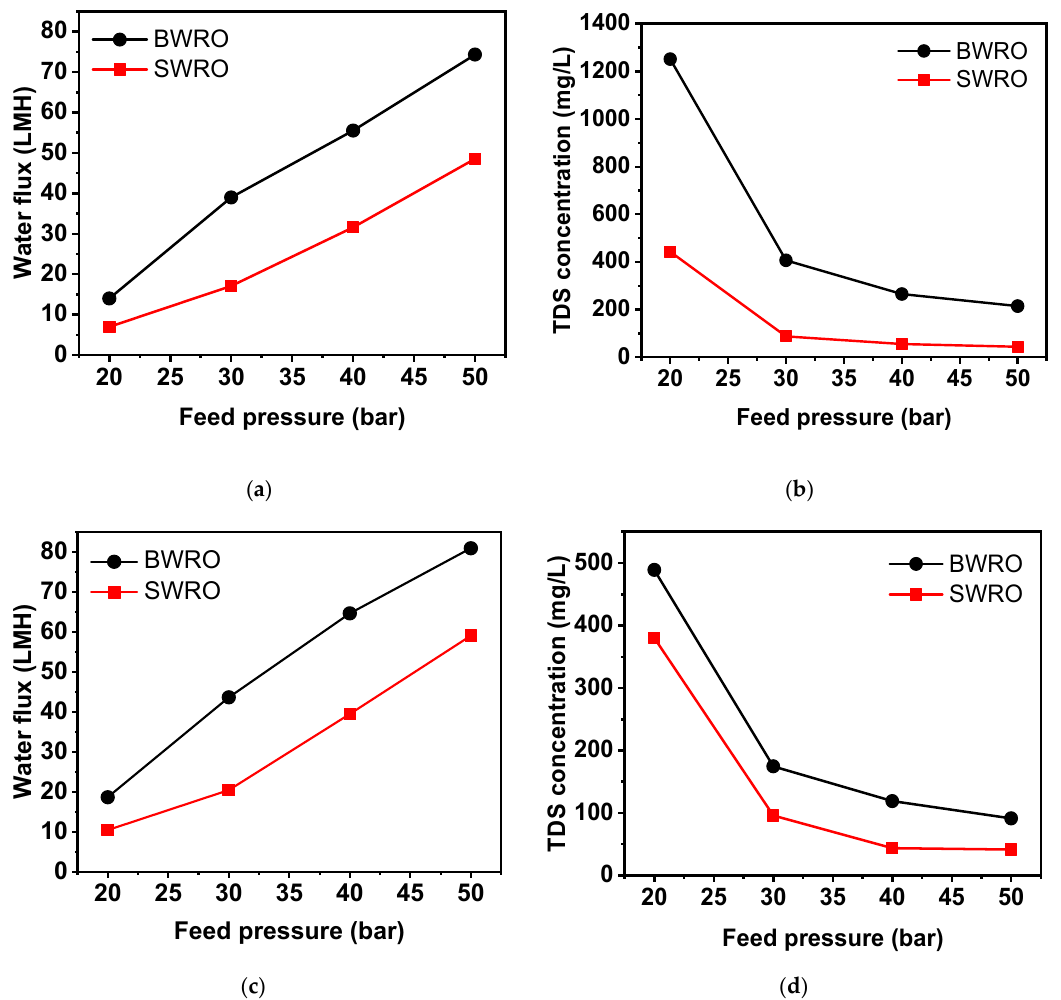
Figure 6. Variation of water flux and permeate TDS concentration by applied hydraulic pressure and membrane types (seawater reverse osmosis (SWRO) and BWRO) in feed concentration of 20,000 mg/L ( a , b ) and 15,000 mg/L ( c , d ).